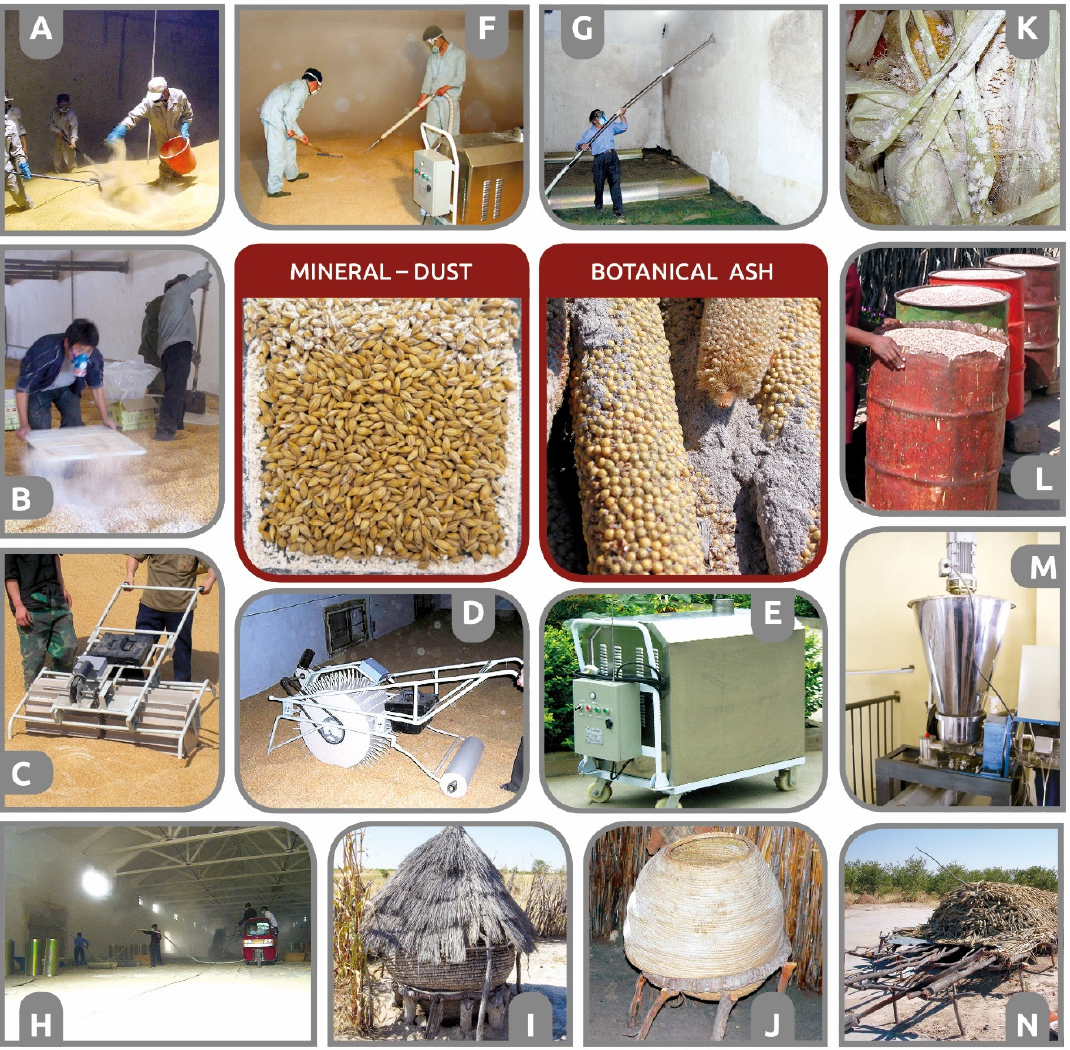
Figure 6. ( A , B ) Various types of manual applications of inert dusts for surface and subsurface grain treatment in horizontal stores; ( C , D ) two types of motorized blenders for surface and subsurface grain treatment in horizontal stores (ASAG-Beijing); ( E ) one purpose-built automatic dust applicator machine (ASAG-Beijing); ( F ) surface and subsurface manual ap- plication with the help of an automatic dusting machine; ( G ) application of dust on the wall of a horizontal store with the help of a dusting machine; ( H ) broadcast structural treatment of an empty store with inert dust; ( I , J ) surface of empty storage wickerwork baskets treated using inert dust or ash; ( K ) visualization of the layer treatment of maize cobs using diatomaceous earth dust; ( L ) grain stored in drums treated using botanical ash; ( M ) dust applicator for continual grain treatment on a conveyor belt inside a silo building (ASAG-Beijing); ( N ) short-term outdoor storage of commodities treated using botanical ash. Note: Photographs A–H were kindly provided by Prof. Dr. Cao Yang and Prof. Dr. Yanyu Li (Acad-